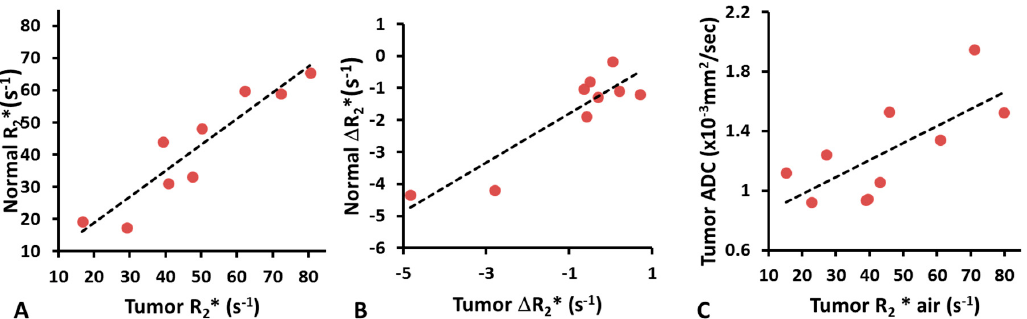
Figure 3. Correlations between MRI parameters. ( A ) Correlation between R 2 * of tumor and normal